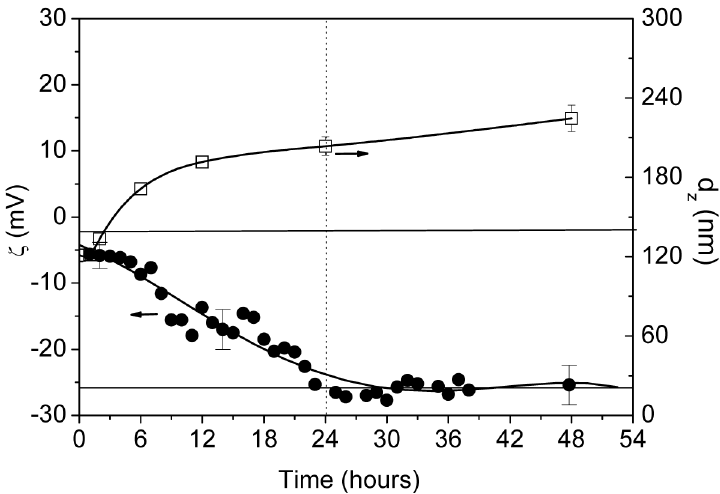
Fig 6. Results obtained from Electrophoretic Mobility experiments. Time evolution of ( ● ) z-potential and ( ◻ ) z-average hydrodynamic radius at T = 298 K for the HPV16 VLPs studied. The error bars indicate the variability of experiments in batch mode performed at t = 0 h, 14 h (or 24h) and 48